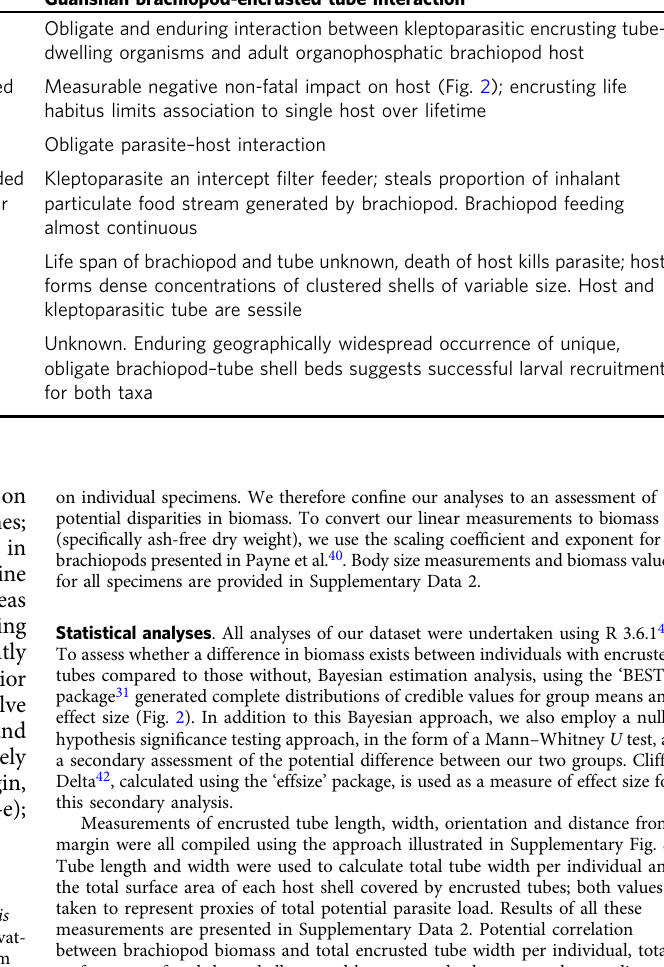
Table 1 Characteristics and requirements of extant sedentary/sessile kleptoparasitic interactions (from ref. 35 ; left) compared with early Cambrian brachiopod – tube interaction from the lower Cambrian (Stage 4) Guanshan Konservat-Lagerstätte